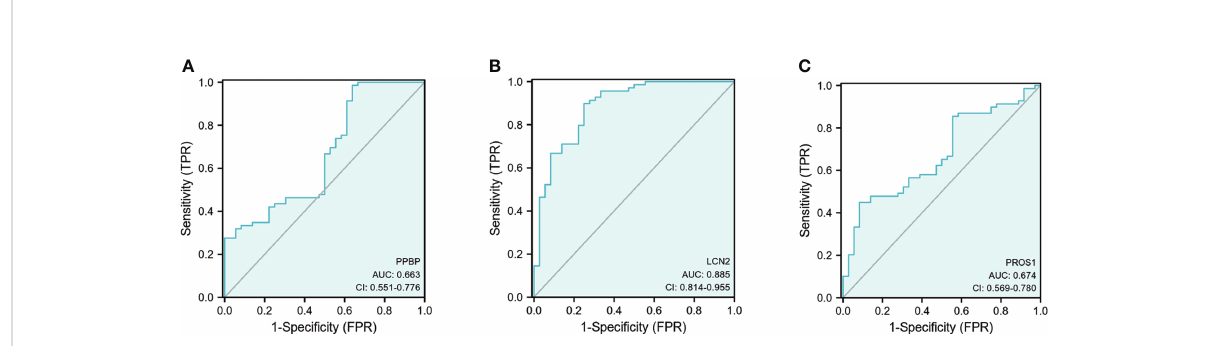
FIGURE 10 Receiver operating characteristic (ROC) curves of PPBP, ROS1, and LCN2. (A – C) The ROC of PPBP, ROS1, and LCN2. sensitivity (true-positive rate) and 1-speci fi city (false-positive rate); AUC: area under curve; CI: 95% con fi dence